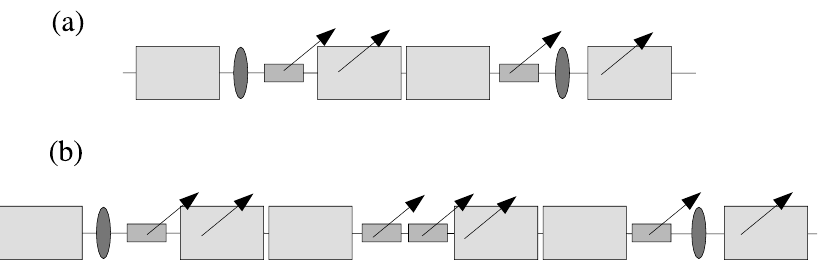
FIG. 3. Arrangements of components requiring significant but manageable changes to the APS optics (after Sajaev [24]). These arrangements provide chirped pulses to more beam lines for the same cost compared those in Fig. 1. In the first arrangement (a) chirped pulses are provided to two undulator beam lines and one bending magnet beam line. In the second arrangement (b) chirped pulses are provided to four undulator beam lines and two bending magnet beam lines. The many quadrupoles and sextupoles that exist in the lattice are omitted from this drawing, for clarity.